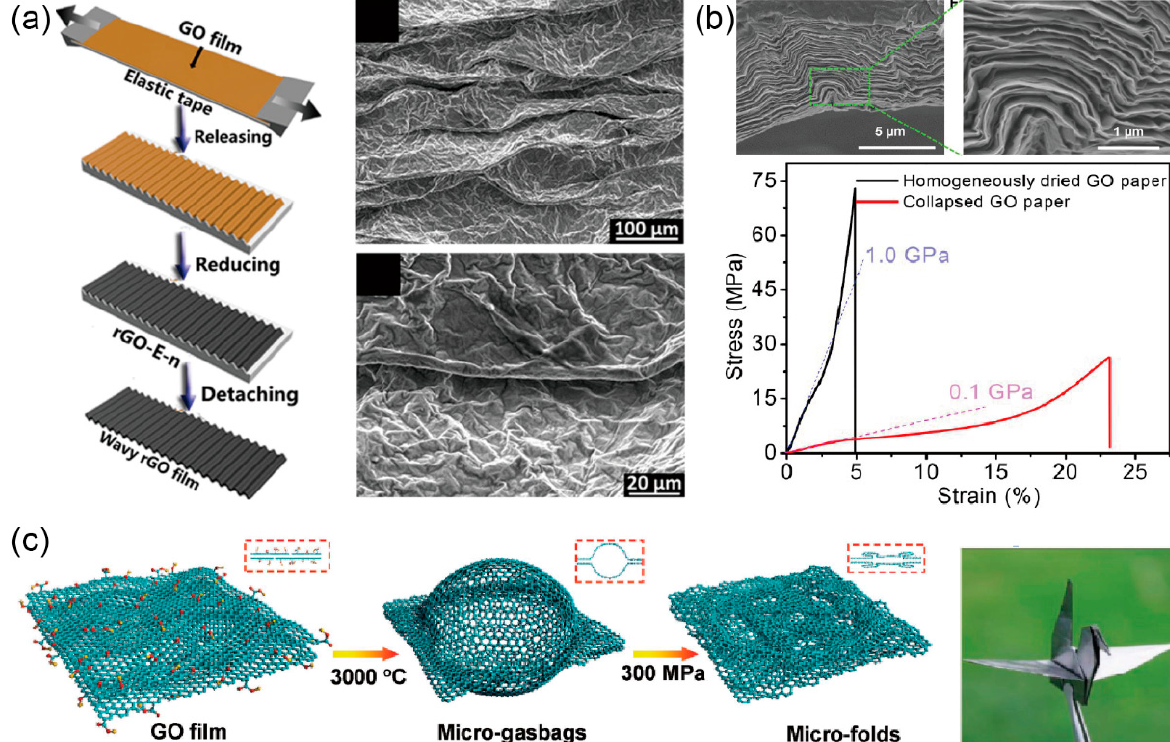
Figure 12. Improving the flexibility of graphene papers (GPs). ( a ) Surface wrinkling method and top view of the resultant wrinkle morphology. Reprinted with permission from [153]. ( b ) Rubber-like GPs with hierarchical crumples obtained by sheet collapsing approach. Reprinted with permission from [125]. ( c ) Thermal annealing approach and resultant highly flexible GPs with micro folds. Reprinted with permission from [141].